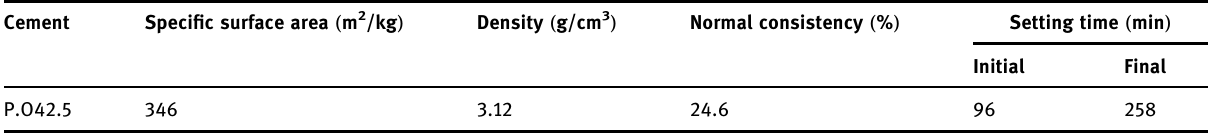
Table 2: Performance parameters of cement Cement